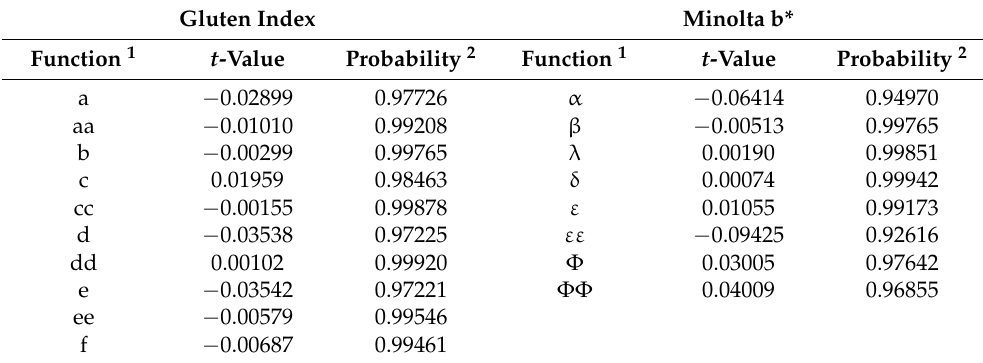
Table 6. Test of the similarity of the original data set and that estimated using regression functions using a paired t